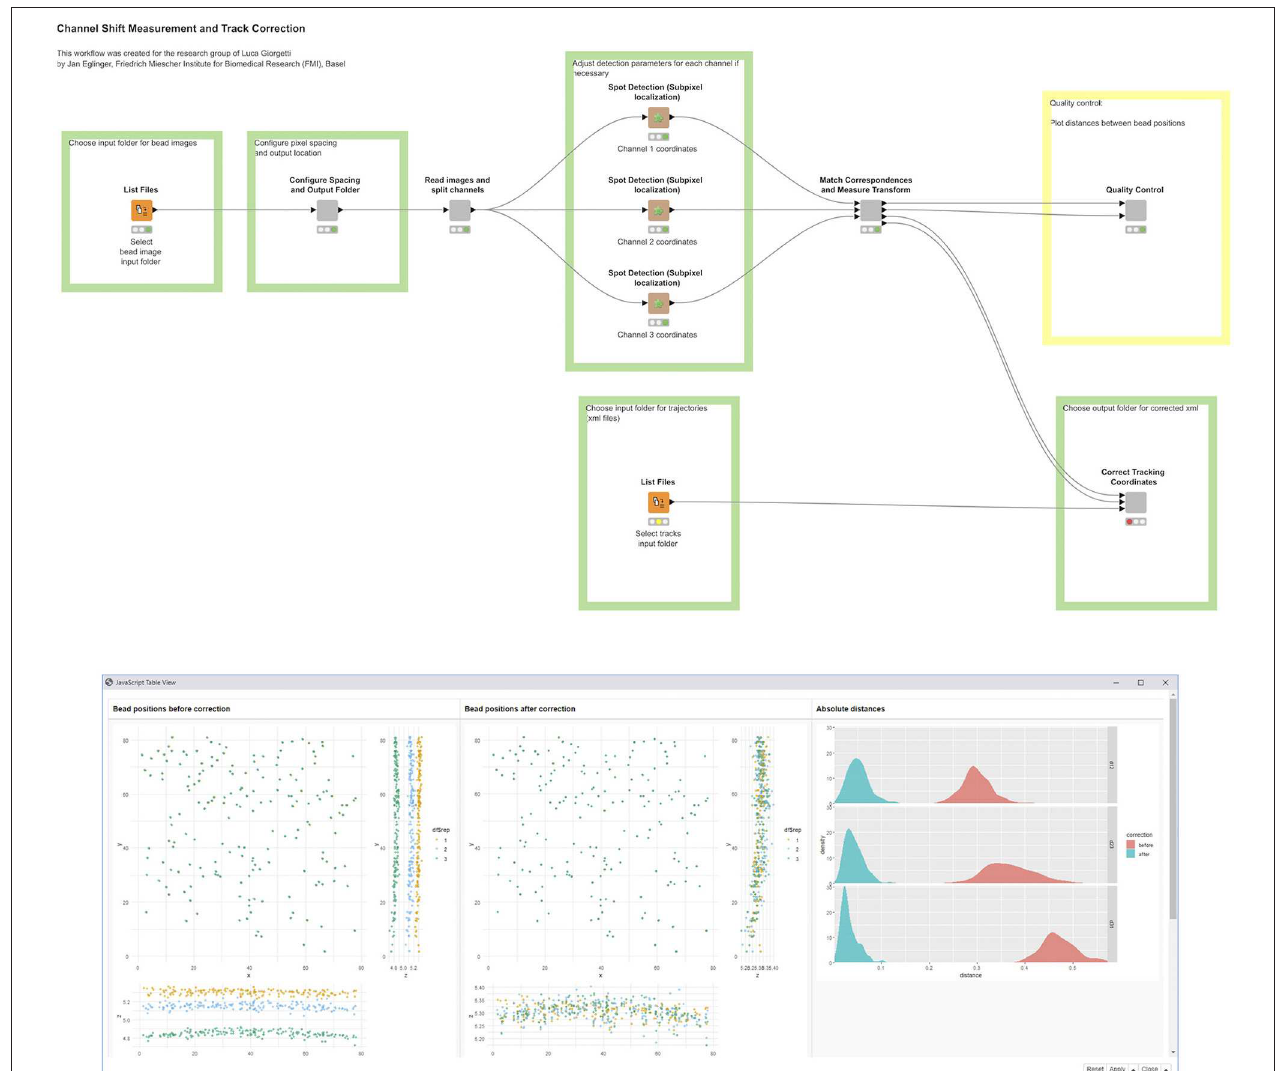
FIGURE 7 | A KNIME workflow for channel-shift correction and particle tracking. The positions of bead detections are shown in three-pane scatter plots, before (left) and after (right) applying channel-shift correction. The density plots show absolute distances between apparent bead locations of two channels (red) and after (cyan)